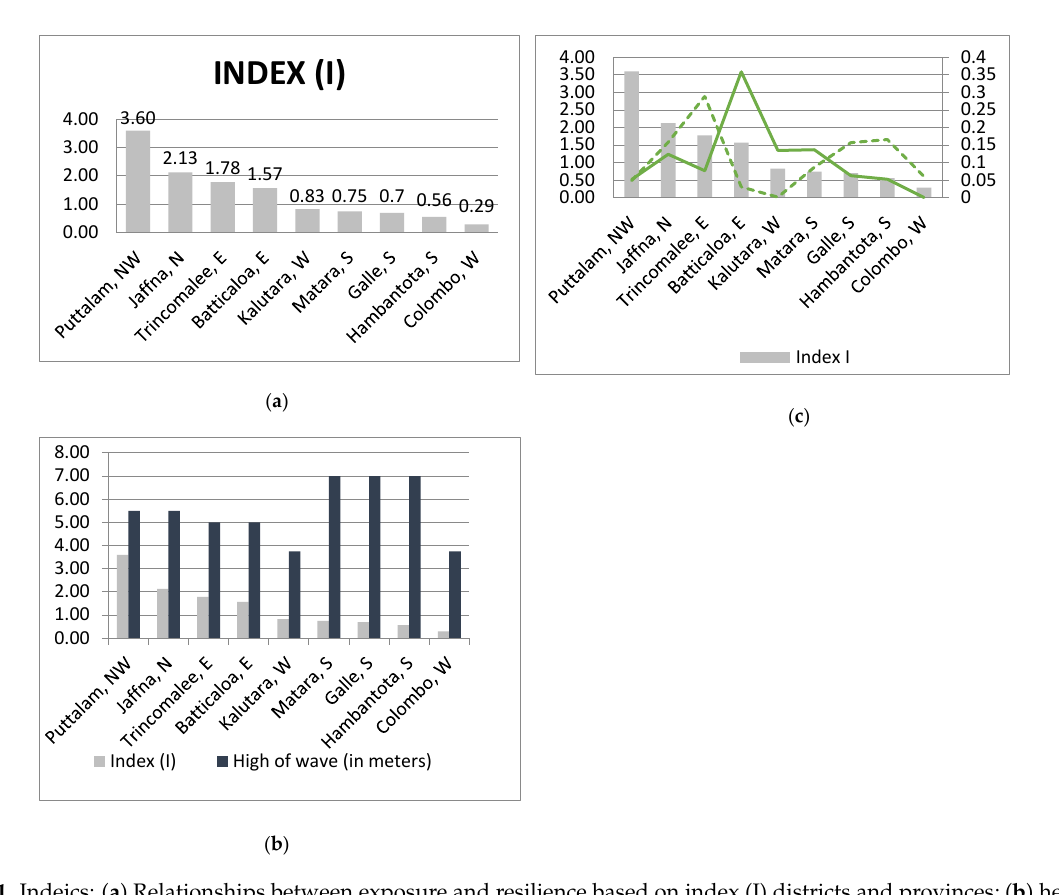
Figure 1. Indeics: ( a ) Relationships between exposure and resilience based on index (I) districts and provinces; ( b ) height of wave and index (I); ( c ) indices of destroyed houses by type: complete destruction and partial destruction of houses.